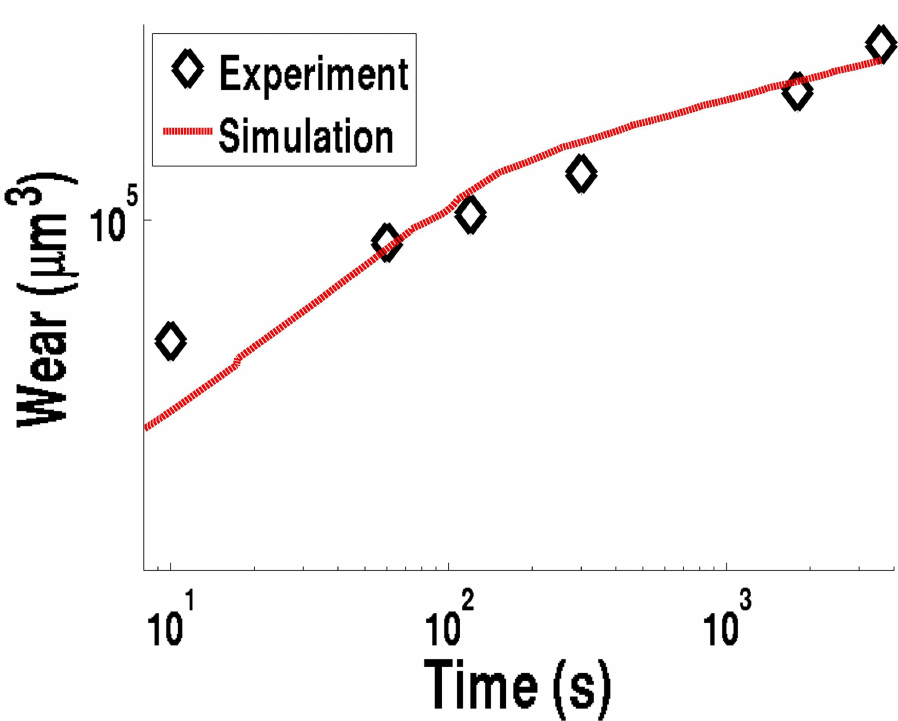
Fig 9. Wear ( μ m 3 ) experimental data and matching simulation results, for neat mineral oil at a bulk lubricant oil temperature of T = 51˚C.